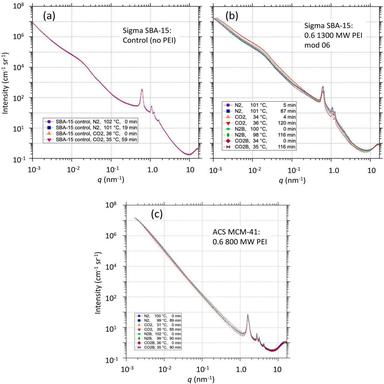
Slit-smeared, absolute-intensity calibrated USAXS/SAXS data versus q for key (a) SBA-15 control, (b) PEI/SBA-15 and (c) PEI/MCM-41 powder sample runs.